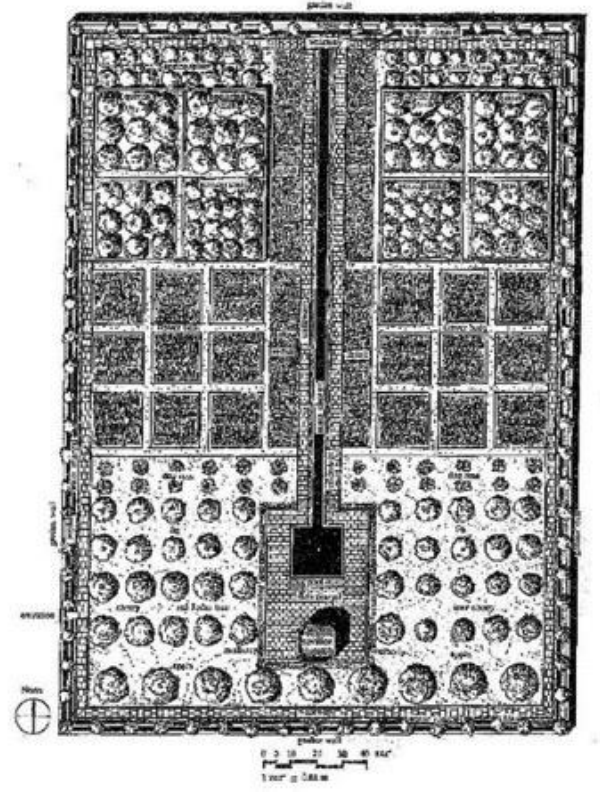
Figure 16. The pattern of production in a typical chahar bagh (Subtelny